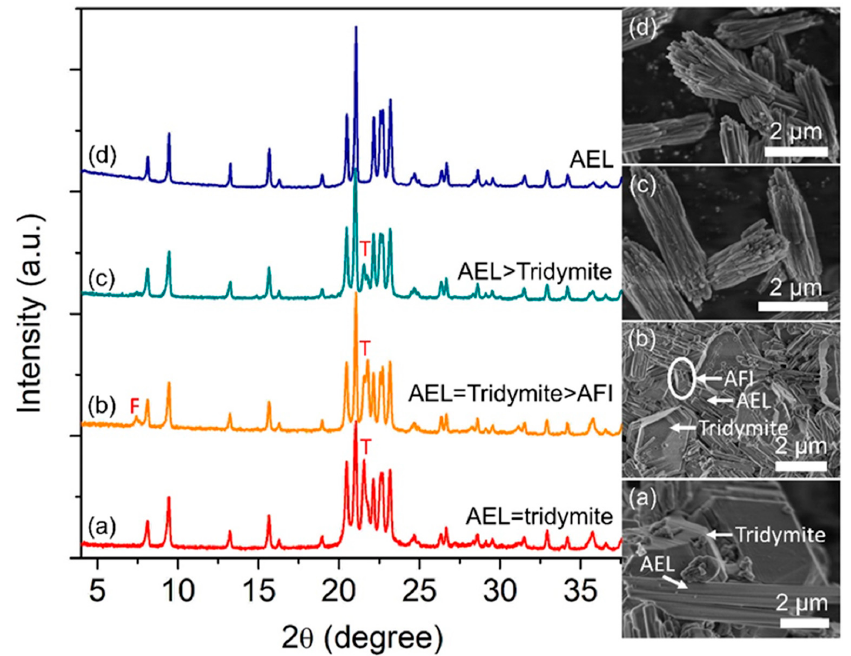
Figure 4. XRD patterns and FESEM micrographs of ( a ) E-11 ( y = 0), ( b ) E-12 ( y = 0.4), ( c ) E-3 ( y = 0.9) and ( d ) E-13 ( y = 1.3) samples. The samples were prepared using the ionogel of 1.0Al: 1.8P: y Si: 38[PPy]Br heated at 150 °C for 133 h. F and T denote the presence of AFI and tridymite crystalline phases, respectively.